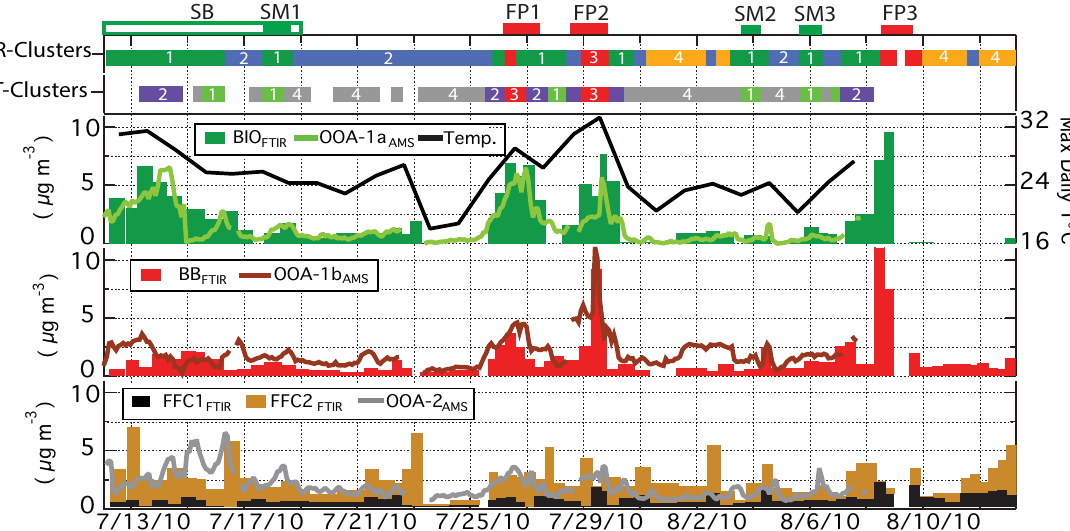
Fig. 3. Time series of submicron OM reconstructed from PMF analysis on AMS and FTIR spectra and clusters of FTIR spectra (IR-Clusters) and tracers (T-Clusters). (Top) Times series of IR-Clusters: Cluster 1-1R (green), Cluster 2-IR (blue), Cluster 3-IR (red), Cluster 4-IR (orange); and T-Clusters: Cluster 1-T (light green), Cluster 2-T (purple), Cluster 3-T (red), and Cluster 4-T (grey). Bars horizontally span sampling periods for each filter (or filter-averaged period). (Bottom) Time series of AMS and FTIR factors grouped by factor source: biogenic (which includes maximum daily temperature), combustion, and biomass burning. Color bars on top of figure indicate periods of stressed boreal conditions (green outline), sawmill (green box), and fire periods (red